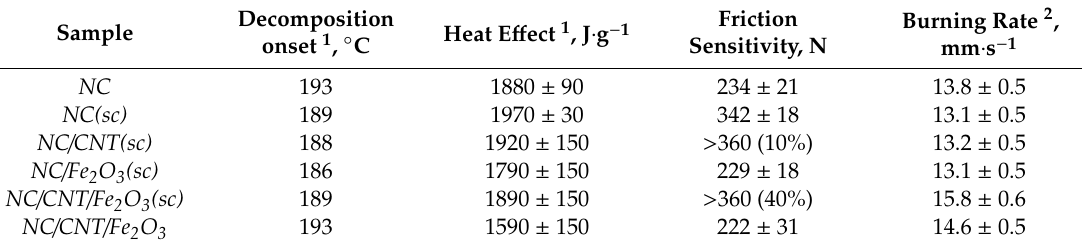
Figure 4. Thermal analysis under linear heating: mass loss ( a ), heat flow ( b ) data, and isoconversional kinetic analysis results ( c ). Table 1. Summary of properties for raw NC and SAS-obtained